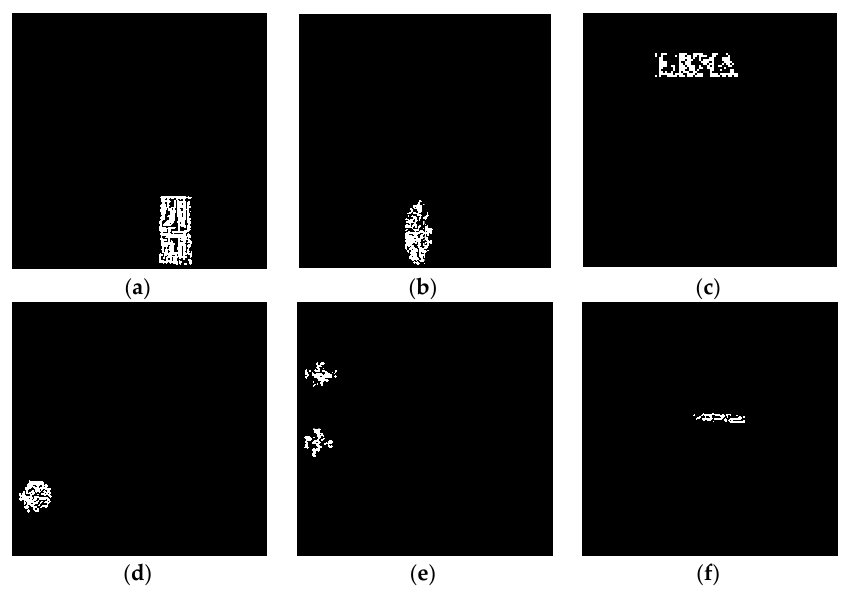
Figure 8. The corresponding tamper localization maps: ( a ) Image cropping; ( b ) Copy–paste attack; ( c ) Text addition; ( d ) Collage attack; ( e ) Content-based attack; ( f ) Constant-average attack.